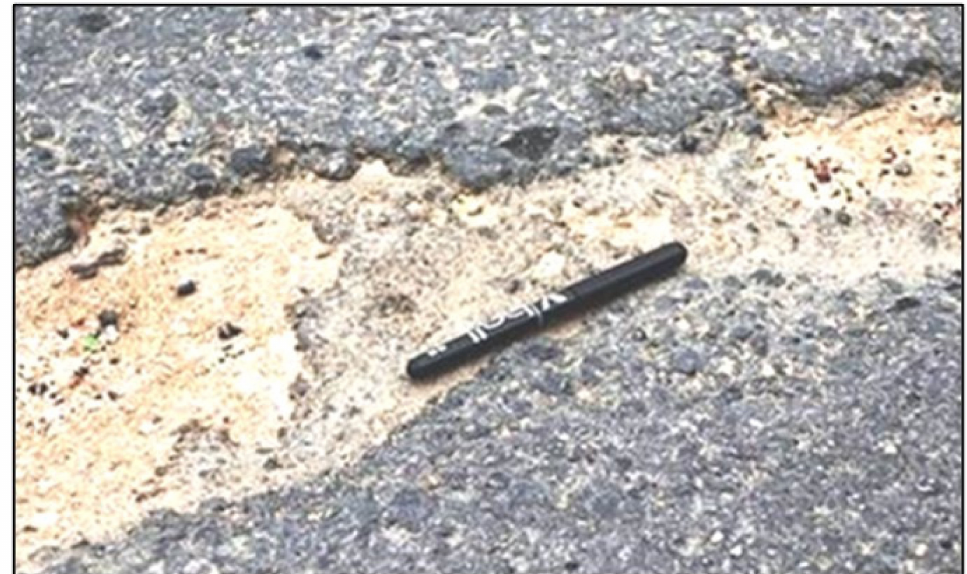
Figure 23. Stripping of asphalt (35 mm) (December 2019) due to placement of the asphalt in wet conditions (rain)—anionic NME stabilised base has been exposed for 2 months during the rainy season (Original material quality: CBR 15 to 25 @ 93% mod AASHTO) (Mpumalanga Province, South Africa).